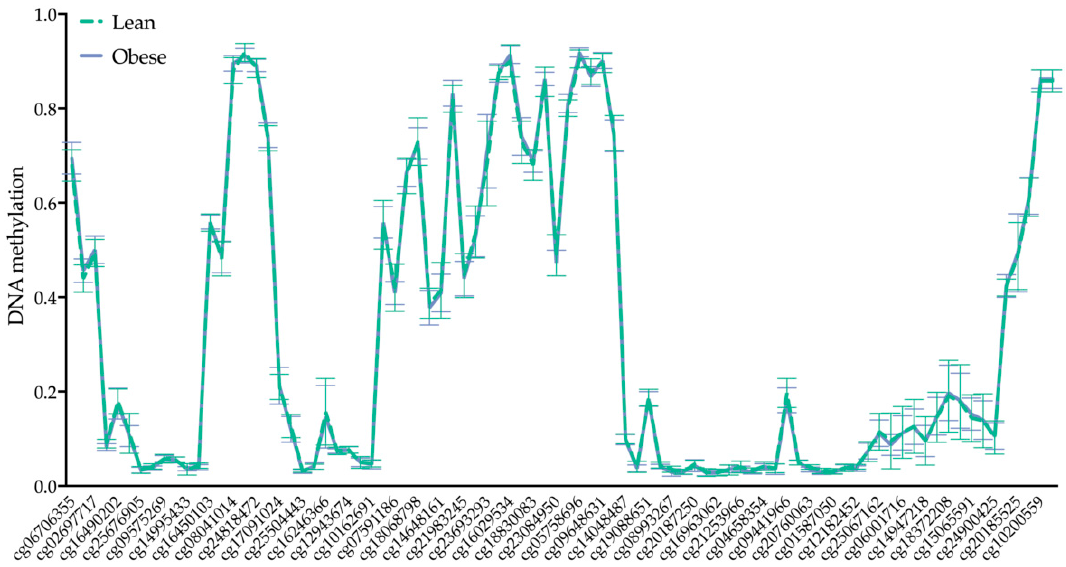
Figure 4. DNA methylation profile of BRCA1 gene is not altered by maternal obesity in the first trimester of pregnancy ( n (lean / obese) = 15 / 15). Genome-wide DNA methylation quantification using Infinium MethylationEPIC Array (850 K) BeadChip included 86 CpGs annotated to the BRCA1 gene.